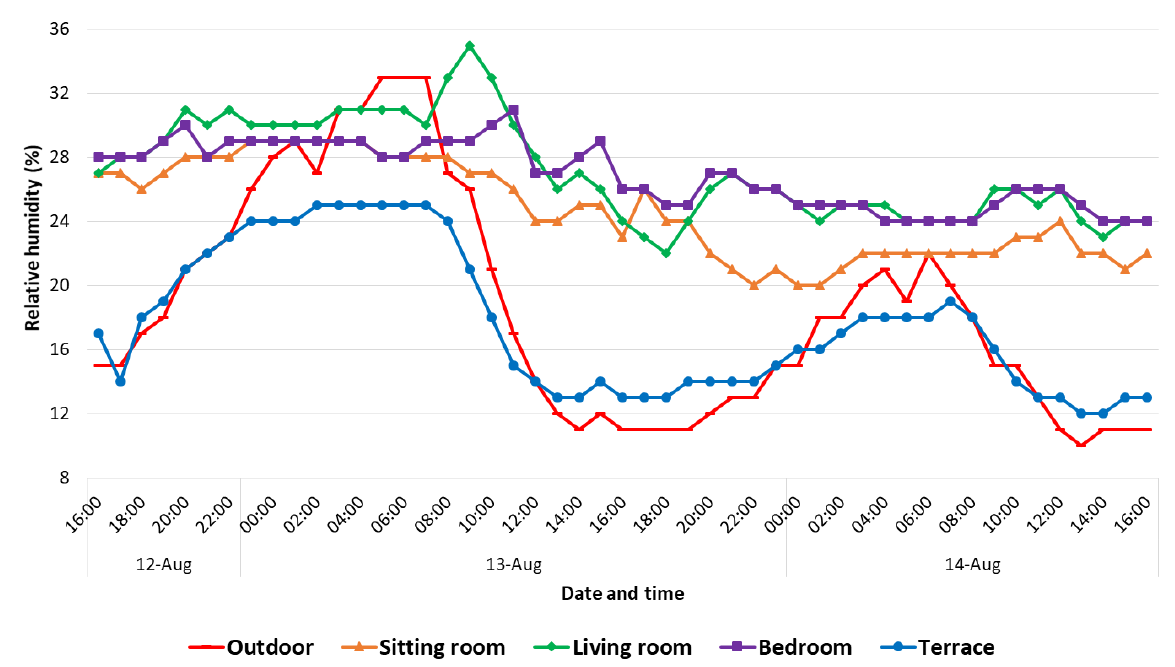
Figure 16. Variation in the indoor and outdoor relative humidity.